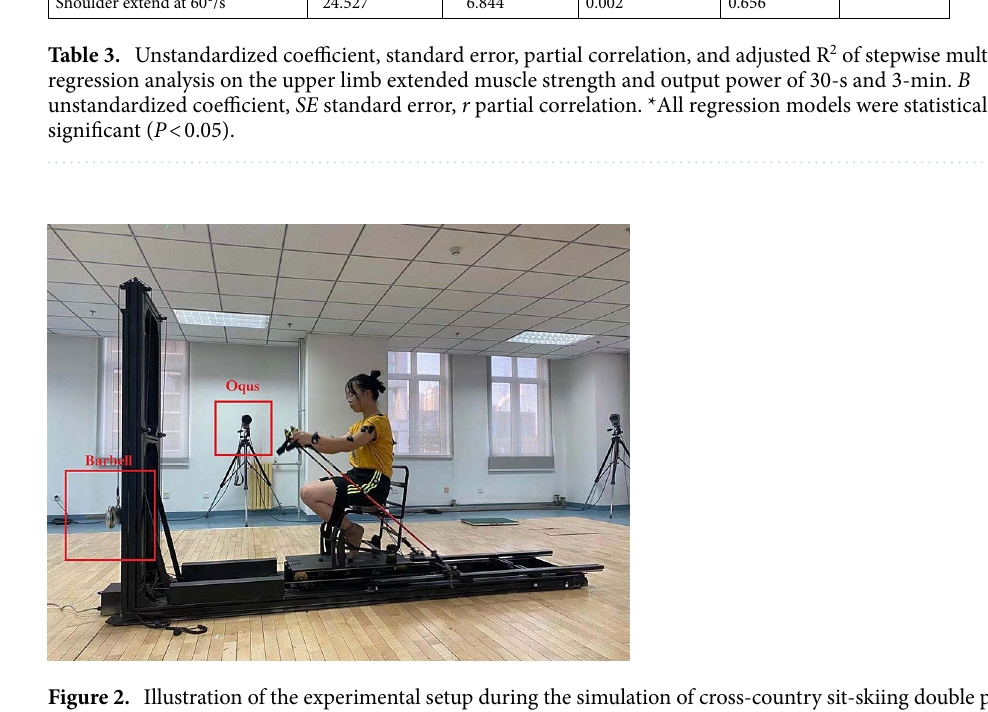
Figure 2. Illustration of the experimental setup during the simulation of cross-country sit-skiing double poling